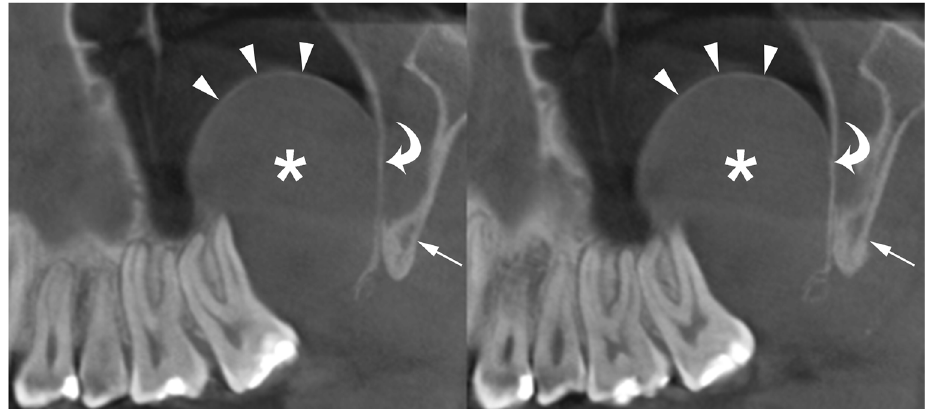
Fig. 9 Panoramic CBCT images of a maxillary OKC ( asterisks ) originating from the molar region distally to the second molar tooth. The OKC causes significant sinus floor elevation ( arrowheads ). Curved arrows , posterior wall of the maxillary sinus; arrows , lateral pterygoid